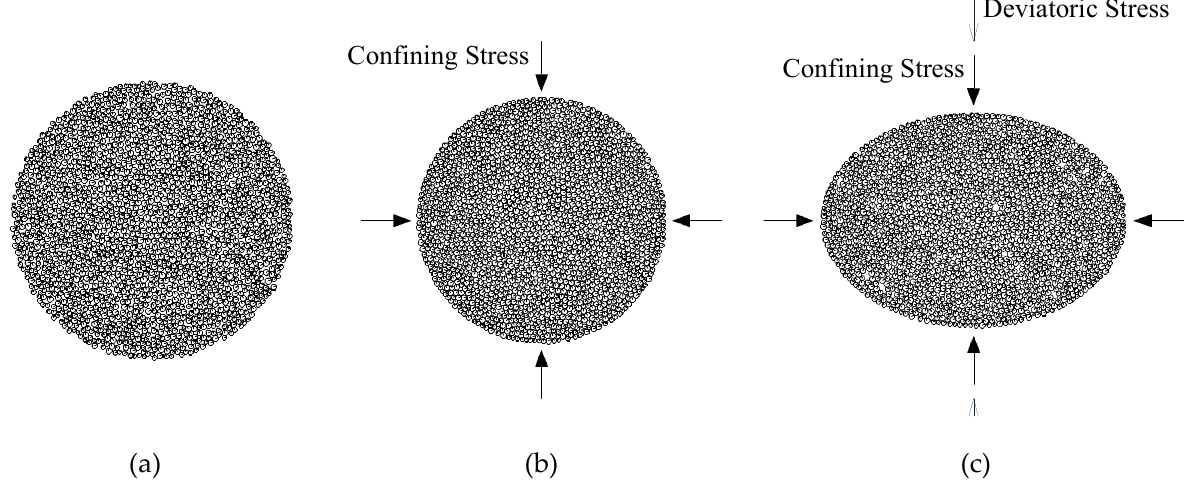
Figure 7. Biaxial test steps: ( a ) Particle generation; ( b ) initial compaction, bonding, and confining stress; ( c ) deviatoric stress step.